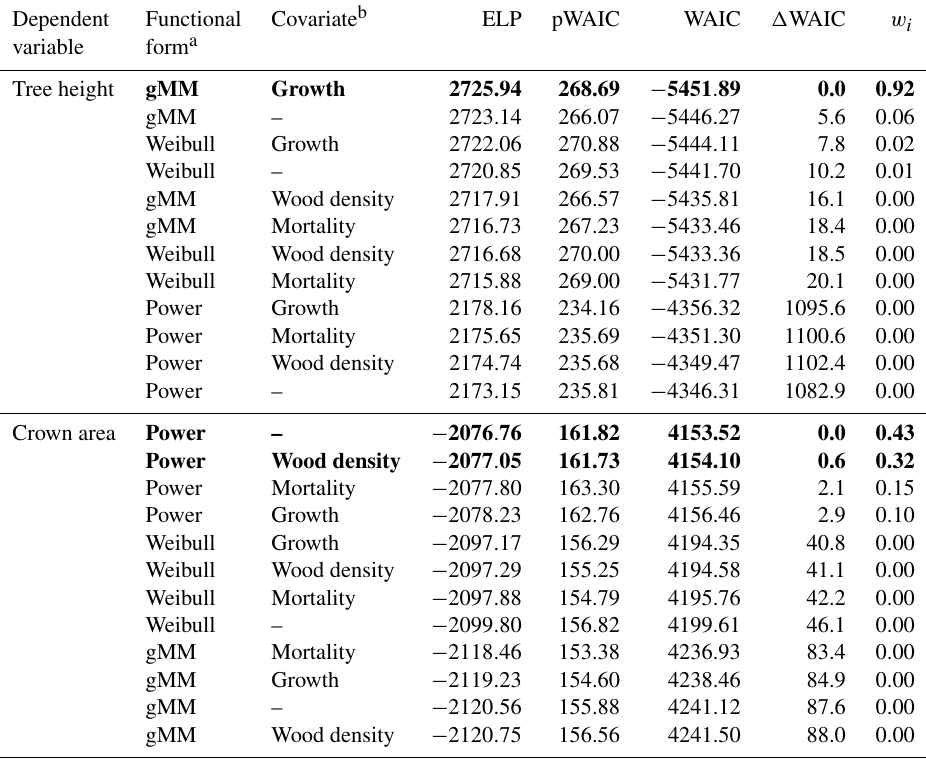
Table 1. Summary of the results of the model selection procedure. We ranked models based on Watanabe’s (2013) widely applicable informa- tion criterion (WAIC), a measure used to identify models with a good balance between predictive power as represented by the expectation of the log pointwise predictive density (ELP) and model complexity as represented by the estimated effective number of parameters (pWAIC). For each model, we report the difference in WAIC from the best model, (cid:49) WAIC. We derived model weights, w i , based on WAIC values to aid in the interpretation of the model selection procedure (Burnham and Anderson, 2002). Models with the lowest WAIC and with (cid:49) WAIC<2 are highlighted in